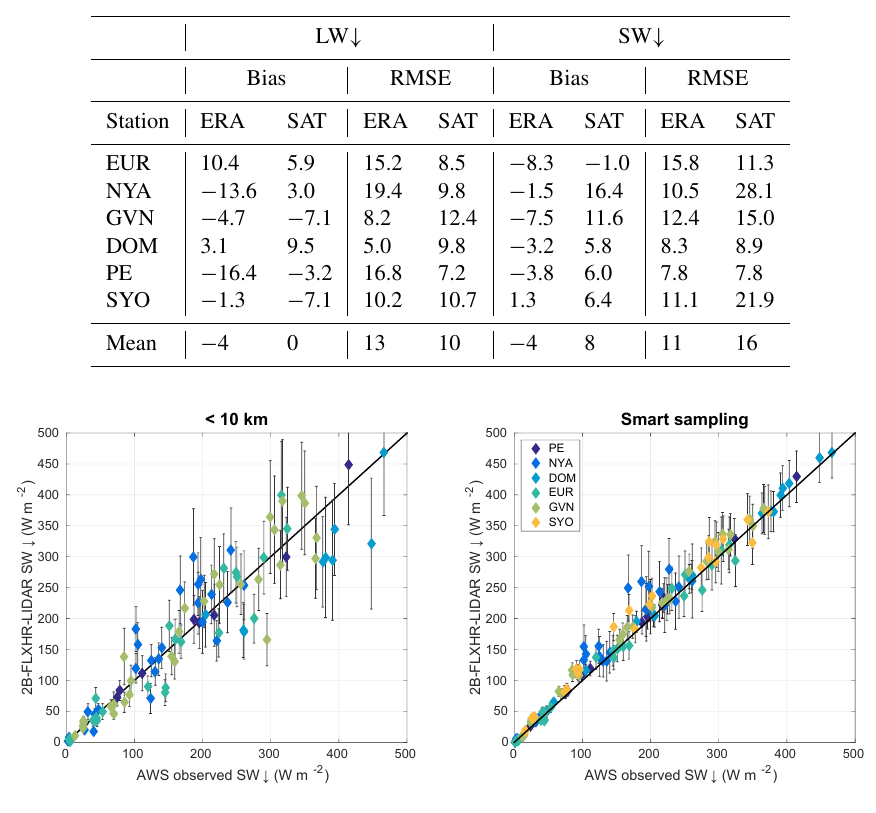
Figure 10. Monthly mean SW ↓ radiation comparison between 2B-FLXHR-LIDAR and AWS (2007–2010). Based on retrievals comprising of all satellite samples <10km from station ( r = 0 . 93) (left). Based on all satellite samples resulting from the smart sampling approach ( r = 0 . 99)